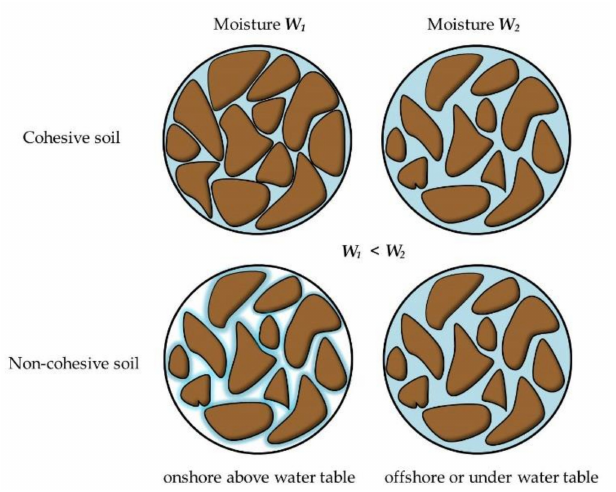
Figure 2. Schematic representation of the elementary volume of cohesive and non-cohesive soil with different moisture